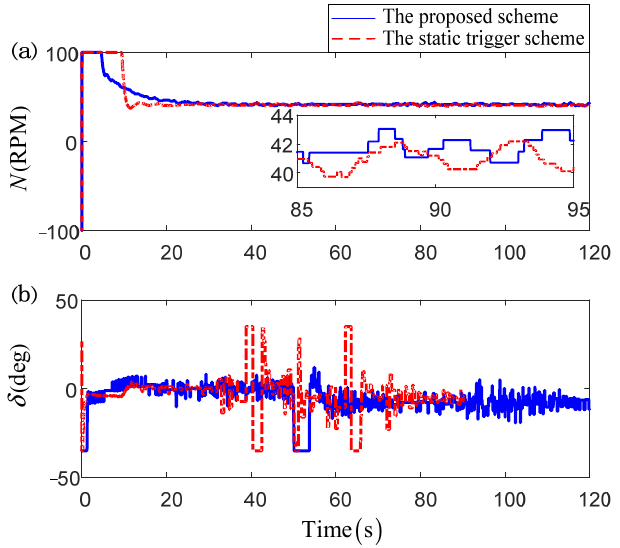
Figure 11. The comparison of control orders: ( a ) the control order of propeller; ( b ) the control order of rudder.